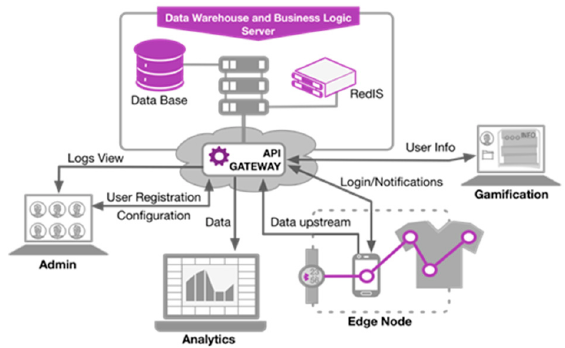
Figure 4. Data Warehouse and Business Logic Server overview and its interoperation with the other elements of the system.